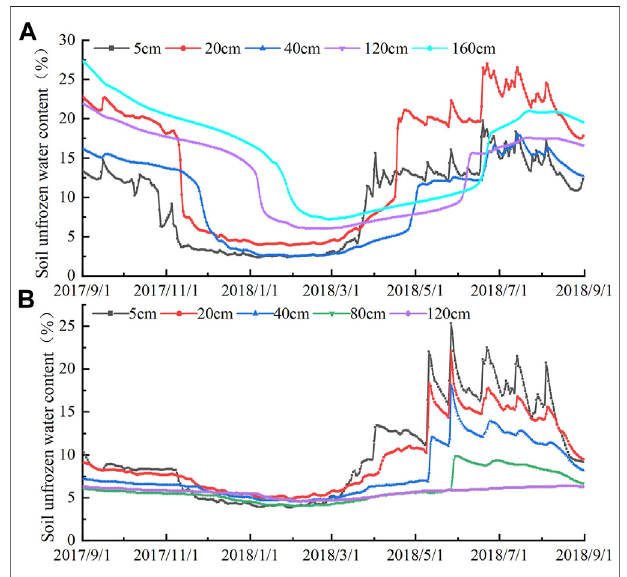
FIGURE 8 | Change curves of soil unfrozen water content at different depths in TS-04 site (A) and TS-05 site (B) .